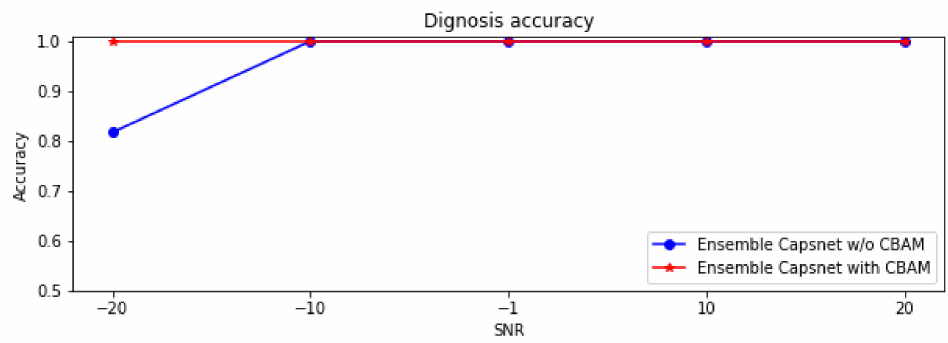
Figure 10. Diagnostic accuracy of ensemble Capsnet with CBAM/without CBAM on different SNR samples.